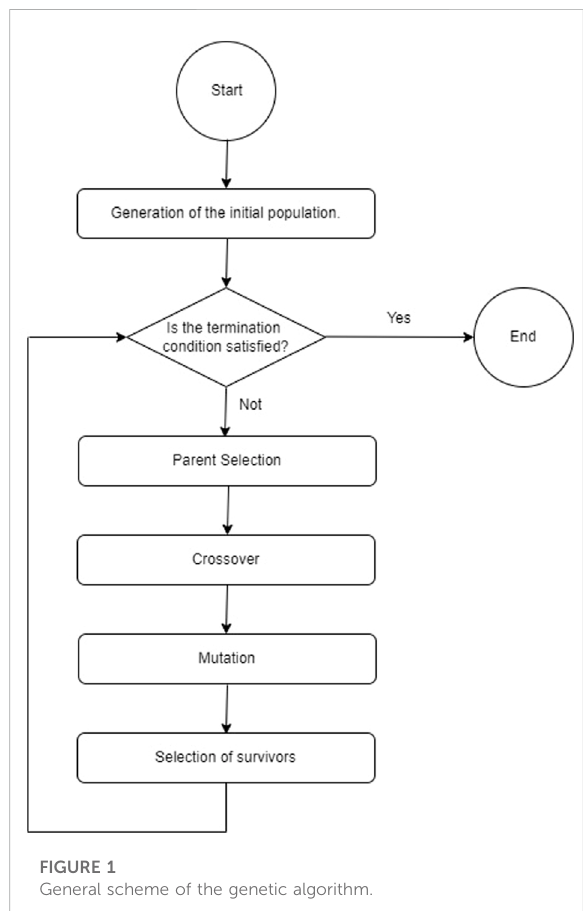
FIGURE 1 General scheme of the genetic